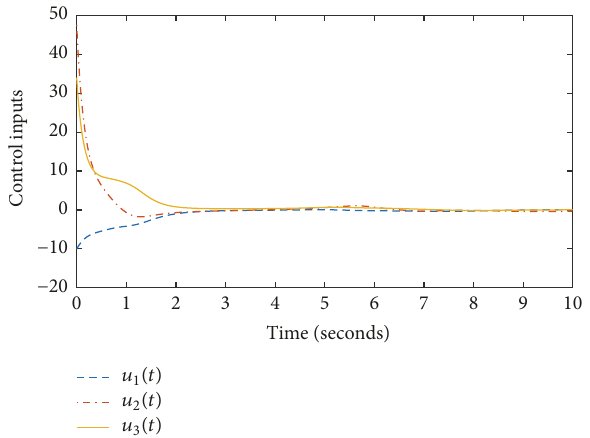
Figure 8: Time response of control inputs 𝑢 1 (𝑡) , 𝑢 2 (𝑡) , and 𝑢 3 (𝑡)